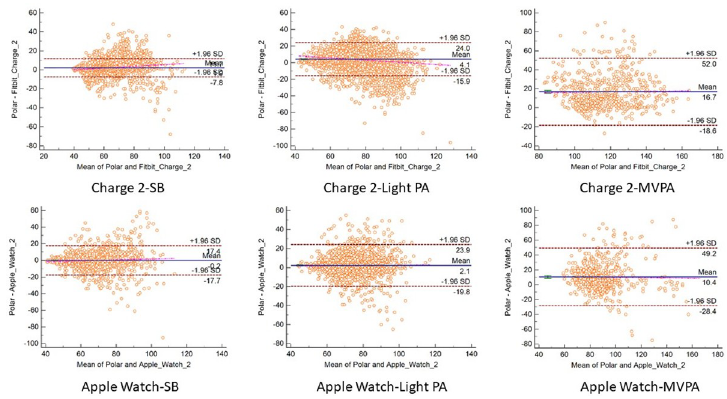
Fig 4. Bland-Altman plots comparing heart rate between Polar H7 and Apple Watch 2 and Fitbit Charge 2.